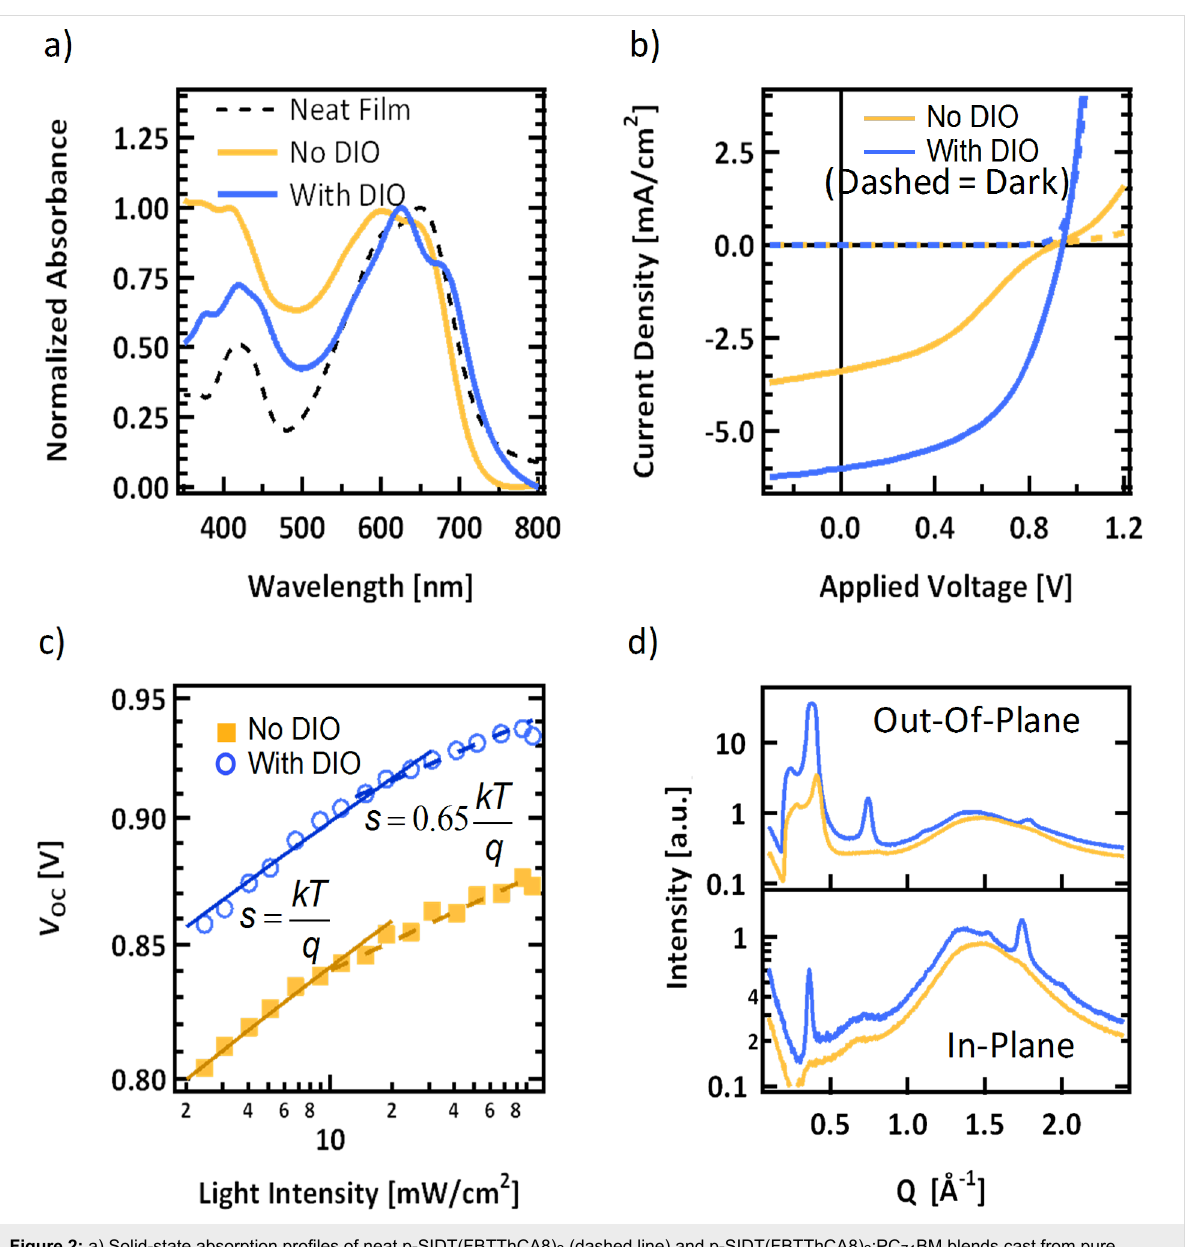
Figure 2: a) Solid-state absorption profiles of neat p-SIDT(FBTThCA8) 2 (dashed line) and p-SIDT(FBTThCA8) 2 :PC 71 BM blends cast from pure chlorobenzene (yellow) and with 1.5% DIO (blue). b) Photovoltaic performance of equivalent blend solar cells with c) corresponding light intensity open circuit voltage measurements where the empirically fit solid lines have a slope of kT / q and dashed lines indicate a slope of 0.65 kT / q , d) blend film X-ray diffraction line cuts from crystallites oriented out-of-plane (top) and in-plane